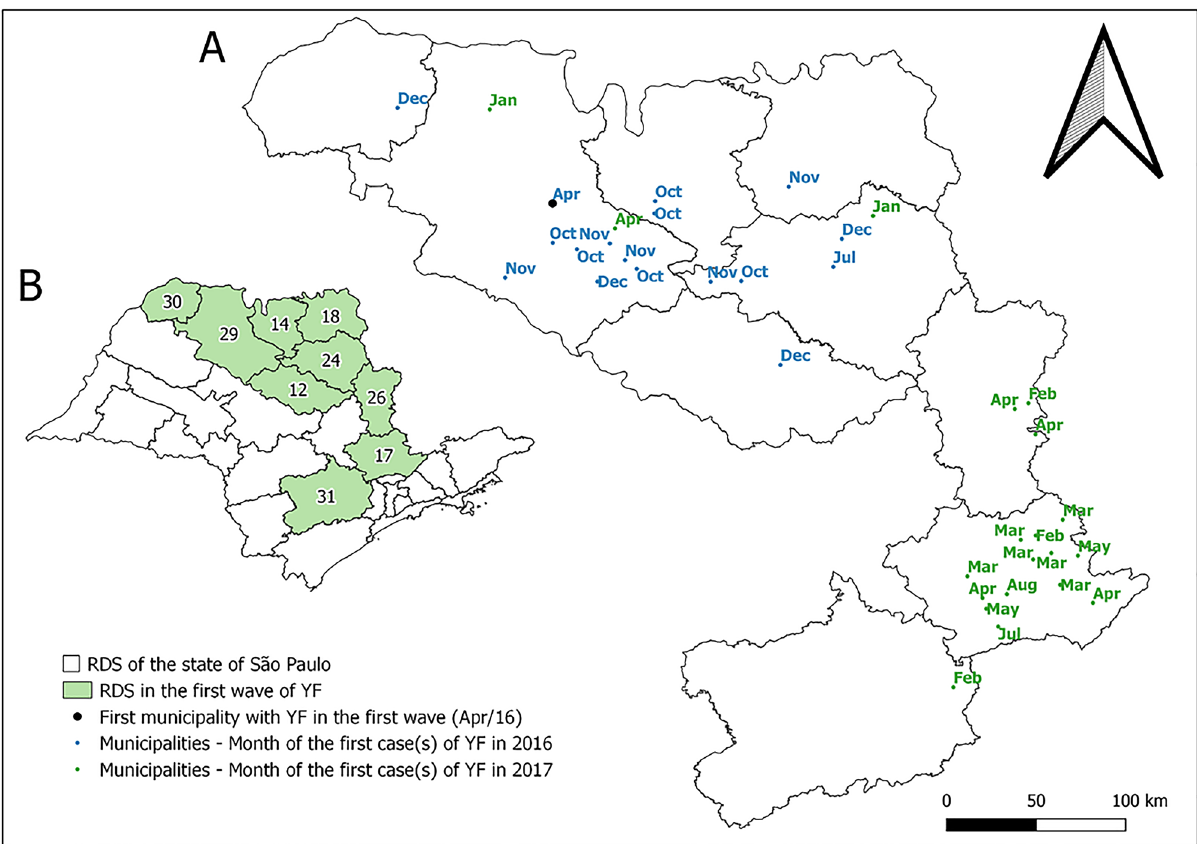
Figure 4. Map ( A ) with the date (month and year) of the first occurrences of yellow fever (YF) (autochthonous human cases, epizootics and both) in the municipalities of the state of São Paulo during the first outbreak wave, April 2016 to August 2017. Map ( B ) presents the Regional Disease Surveillance affected. Maps created using the Free and Open Source